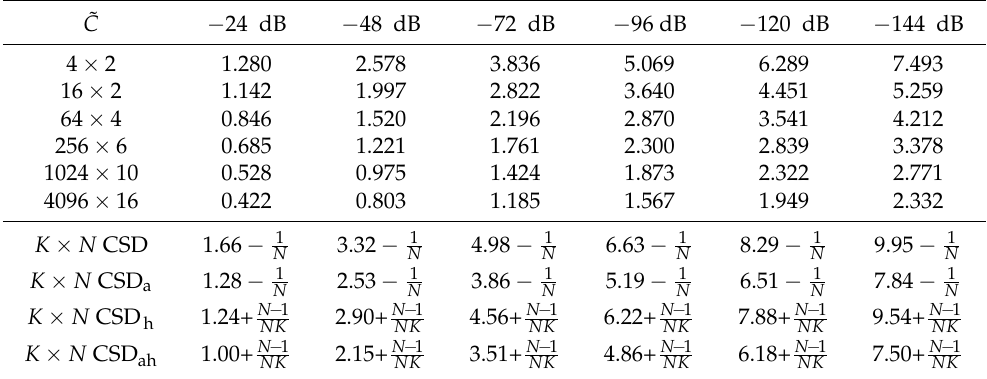
Table 2. Average number of additions per matrix entry that are required to have the median distortion a certain level (between 24 and 144 dB) below the norm of the output